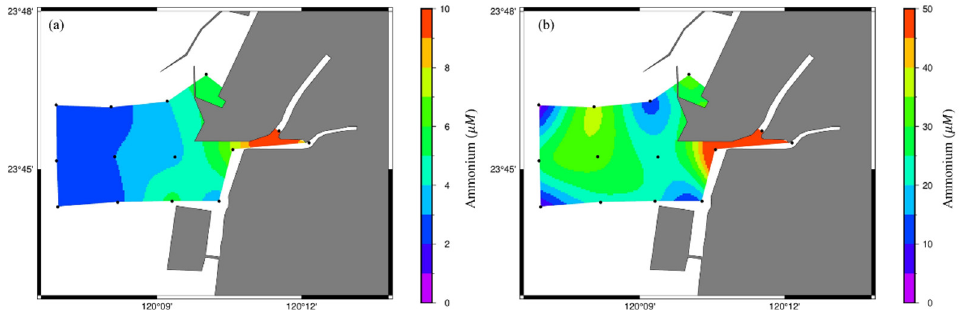
Figure 4. ( a ) Observed ammonium-concentration field for the general case. ( b ) Observed high ammonium-concentration field for a special case measured on 14 August 2020 after heavy rainfall. Note that the color bars show different values in the two diagrams.